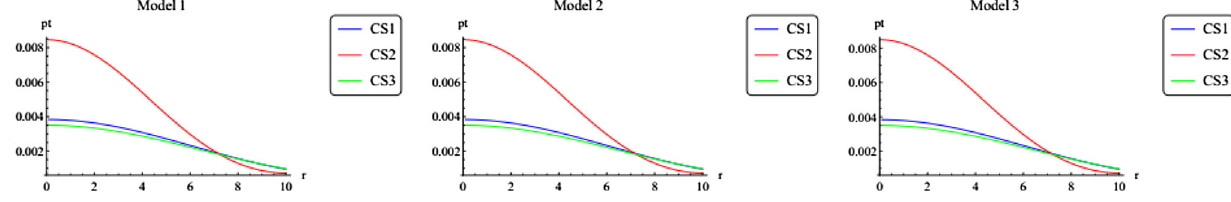
Fig. 3 Evolution of transverse pressure for charged stars, Vela X-1, SAX J 1808.4-3658, and 4U 1820-30, under different viable f ( G ) models Table 3 The approximate values of Central density ρ c and surface density ρ R for three different models